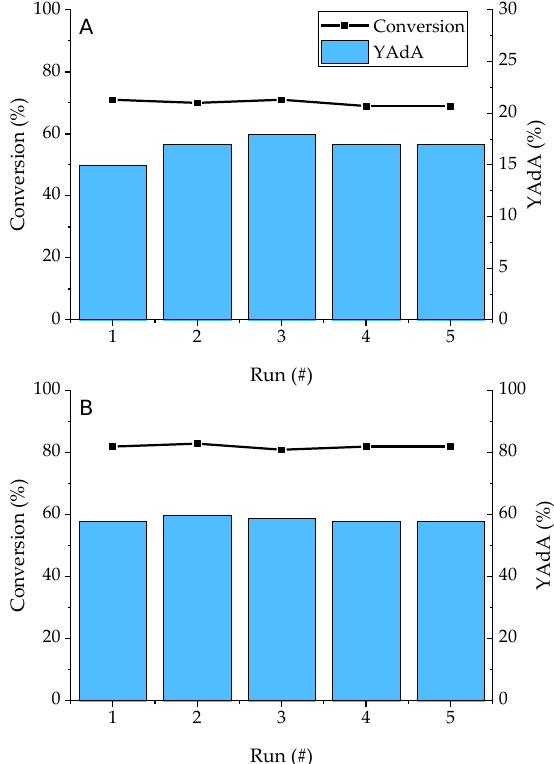
Figure 12. Recycling tests on ( A ) Na-Muc and ( B ) t,t-MA. Reaction time = 15 min.